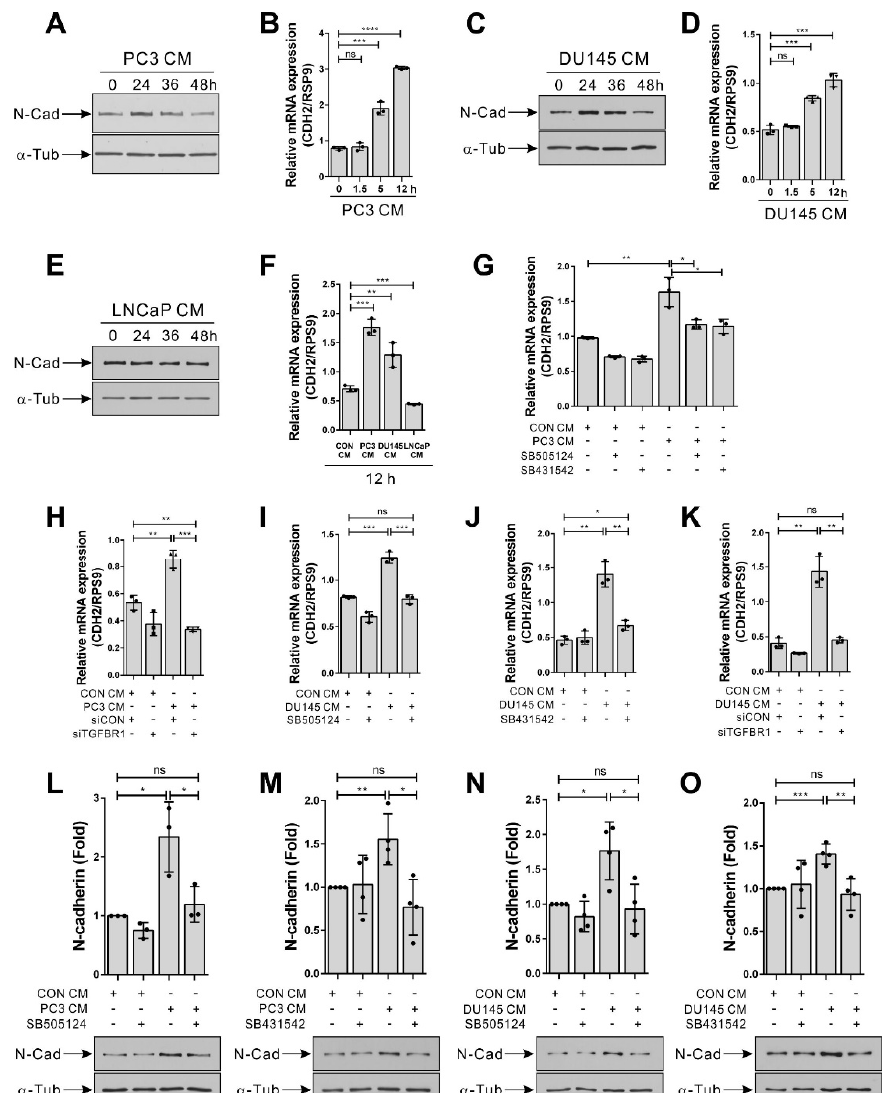
Figure 4. Hormone-insensitive prostate tumor cell-conditioned medium increases the expression of N-cadherin in bone marrow-derived mesenchymal stem cells (BM-MSCs) in a TGF- β -dependent manner. ( A – F ) Western blot analysis of N-cadherin (N-cad) and ɑ -tubulin ( ɑ -Tub) and qRT-PCR analysis of N-cadherin (CDH2). BM-MSCs were treated with the control-conditioned medium (CON CM), the PC3-conditioned medium (PC3 CM), the DU145-conditioned medium (DU145 CM), or the LNCaP-conditioned medium (LNCaP CM) for the indicated times. ( G ) qRT-PCR analysis of N-cadherin (CDH2) in BM-MSCs pretreated with SB505124 (5 µM) or SB431542 (10 µM) for 30 min prior to treatment with CON CM or PC3 CM for 12 h. ( H ) qRT-PCR analysis of N-cadherin (CDH2) in BM-MSCs transfected with control siRNA (siCON) or TGF- β type 1 receptor siRNA (siTGFBR1) prior to treatment with CON CM or PC3 CM for 12 h. ( I,J ) qRT-PCR analysis of N-cadherin (CDH2) in BM-MSCs pretreated with SB505124 (5 µM) or SB431542 (10 µM) for 30 min prior to treatment with CON CM or DU145 CM for 12 h. ( K ) qRT-PCR analysis of N-cadherin (CDH2) in BM-MSCs transfected with control siRNA (siCON) or TGF- β type 1 receptor siRNA (siTGFBR1) prior to treatment with CON CM or DU145 CM for 12 h. ( L – O ) Western blot analysis of N-cadherin (N-cad) and ɑ -tubulin ( ɑ -Tub). BM-MSCs were treated with CON CM, PC3 CM, or DU145 CM for 12 h. Results are presented as the mean ± SD (three to four independent experiments). The statistical significance was determined by the p -value obtained by t -test (* p ≤ 0.05; ** p ≤ 0.01; *** p ≤ 0.001; **** p ≤ 0.0001; ns, p > 0.05). Uncropped Western blot images are available in Figure